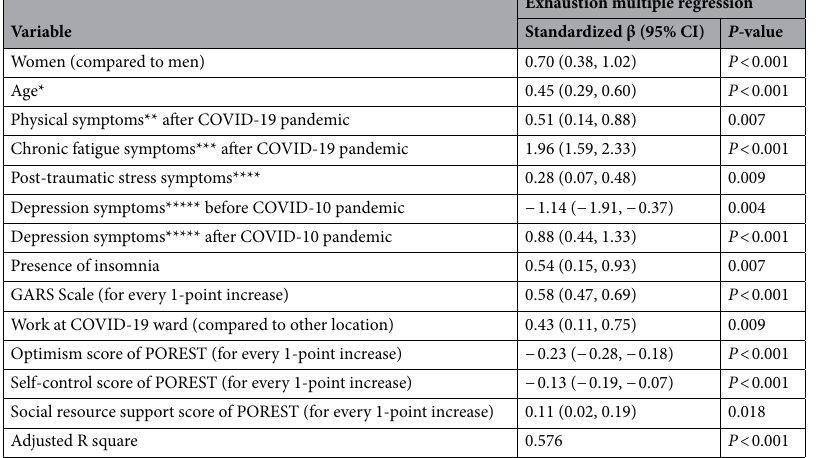
Table 9. Multiple linear regression analyses predicting exhaustion score. CI confidence interval, GARS global assessment of recent stress scale, POREST positive resources test. *60 years and older, 50–59 years, 40–49 years, 30–39 years, 20–29 years, as the age group decreases from the older age group to the lower age group. **Physical symptoms mean a score of 10 or higher on the Patient Health Questionnaire-15. ***Chronic fatigue